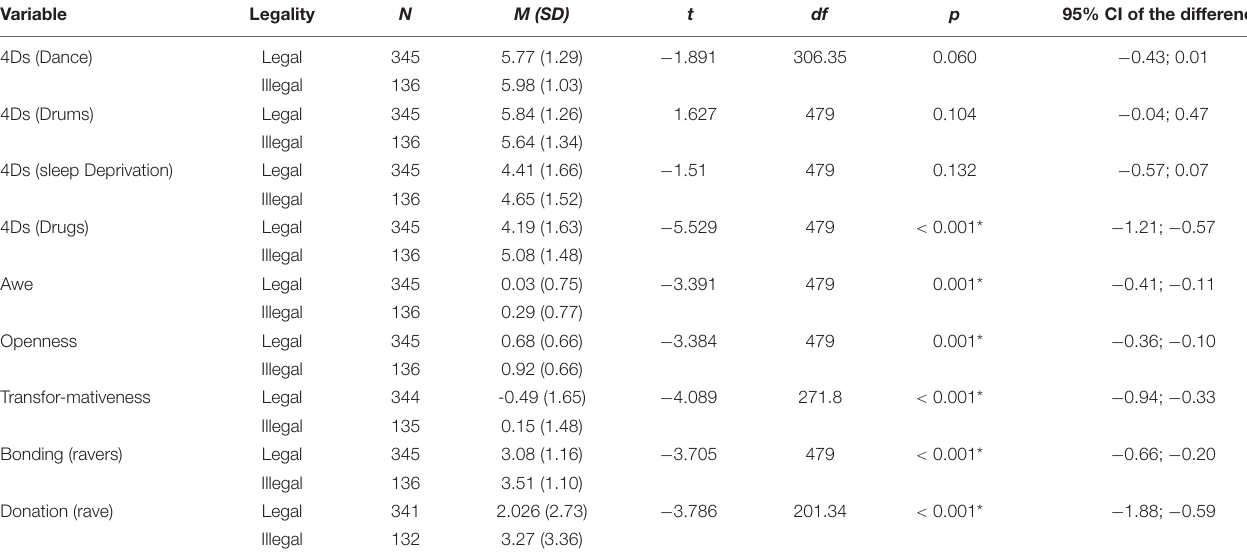
TABLE 5 | Comparing key variables between legal and illegal events.